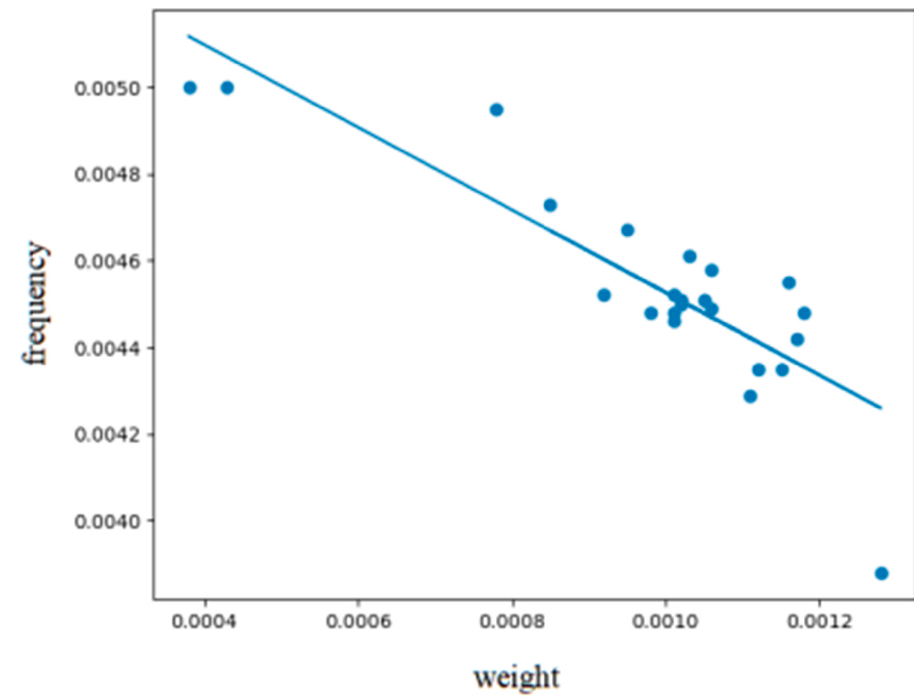
Figure 7. Linear regression model of electronic belt scale weight data and motor frequency.